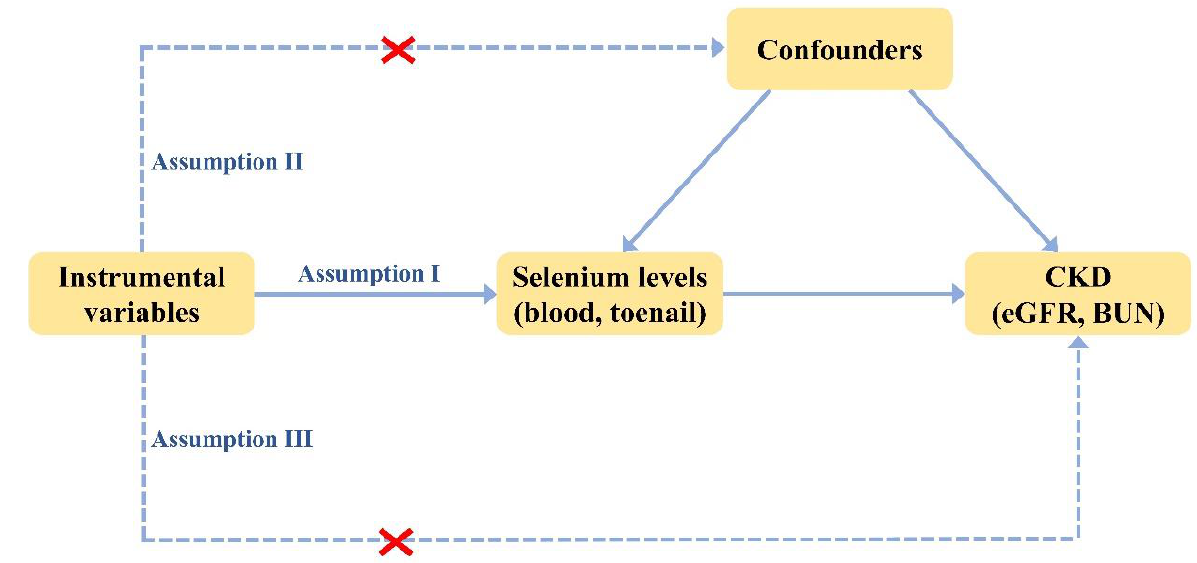
Figure 1. Three basic assumptions in MR analysis.